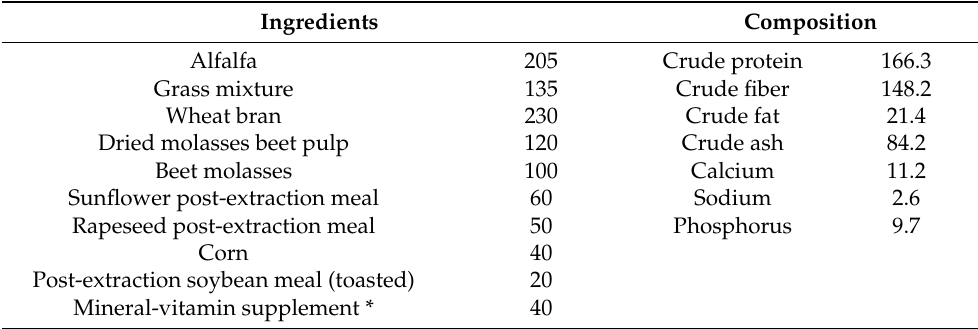
Table 1. Ingredients (g/kg) and chemical composition of granules (g/kg of dry matter) [8]. Ingredients